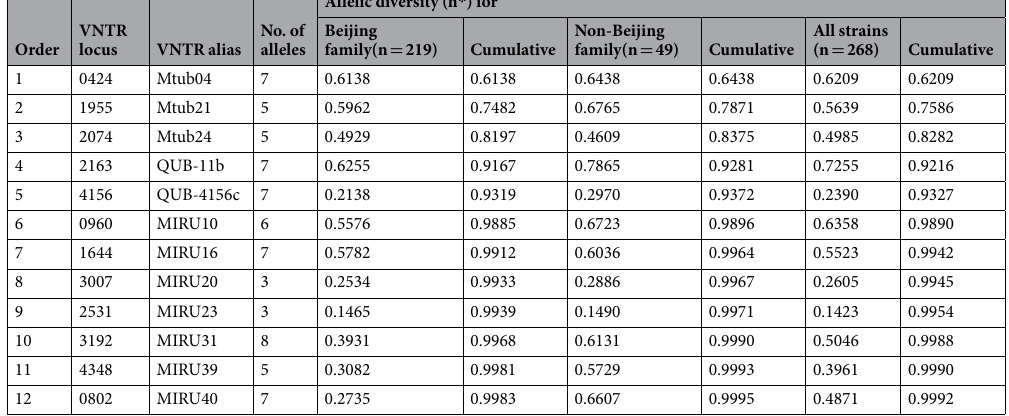
Table 2. The Hunter-Gaston discriminatory index of the 12 VNTR loci in M. tuberculosis strains from Beijing. * h, Hunter-Gaston discriminatory index.